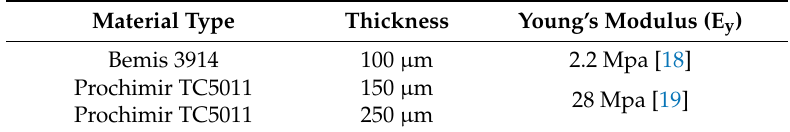
Table 1. Overview and properties of the different thermoplastic polyurethane (TPU) films used.